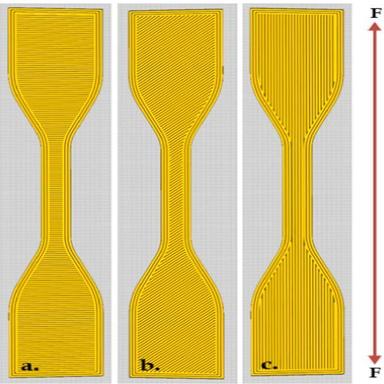
Printing angles: a) 90°; b) 45°; c) 0°.